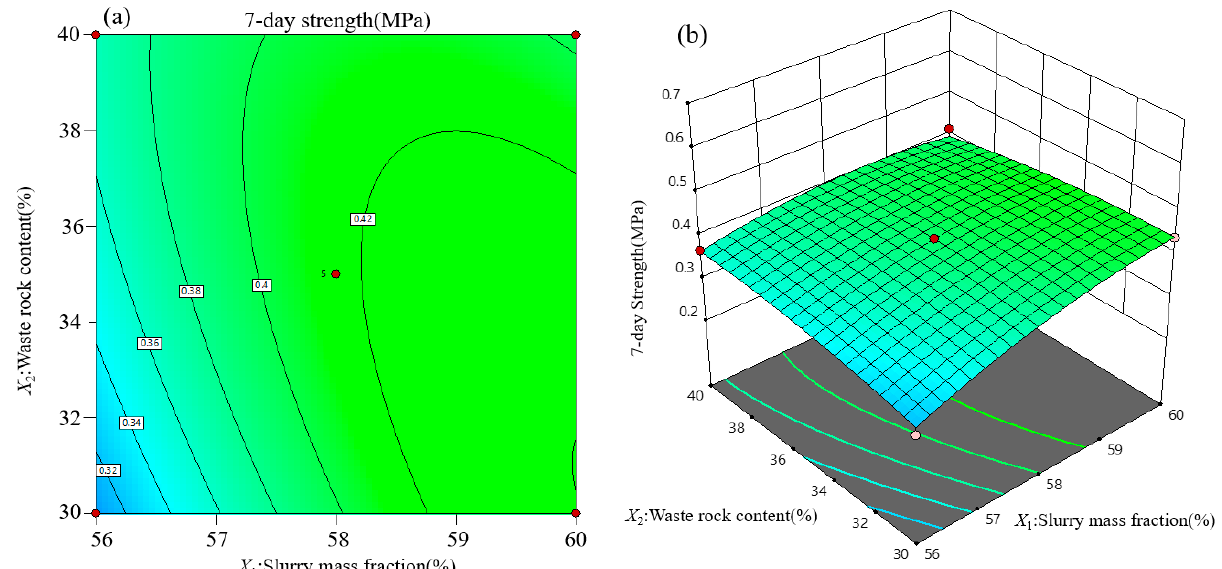
Figure 7. Response surface analysis of influential factors on backfill strength at 7 days: ( a ) contour lines; ( b ) response surface.